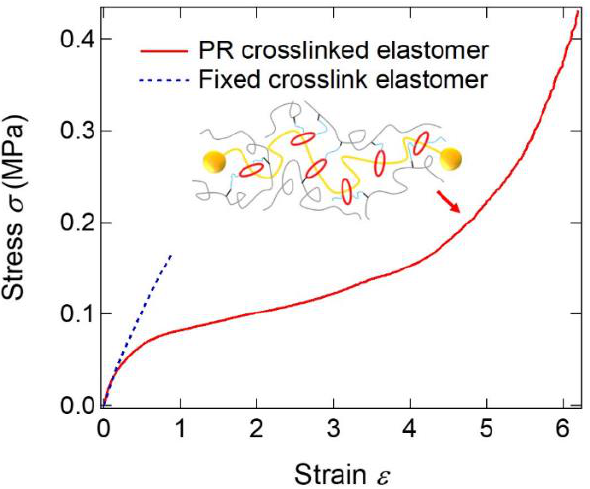
Figure 22. Stress – strain curves of fixed cross-link and PR cross-linked elastomers. Reprinted from Figure 22. Stress–strain curves of fixed cross-link and PR cross-linked elastomers. Reprinted [40]. from [40].